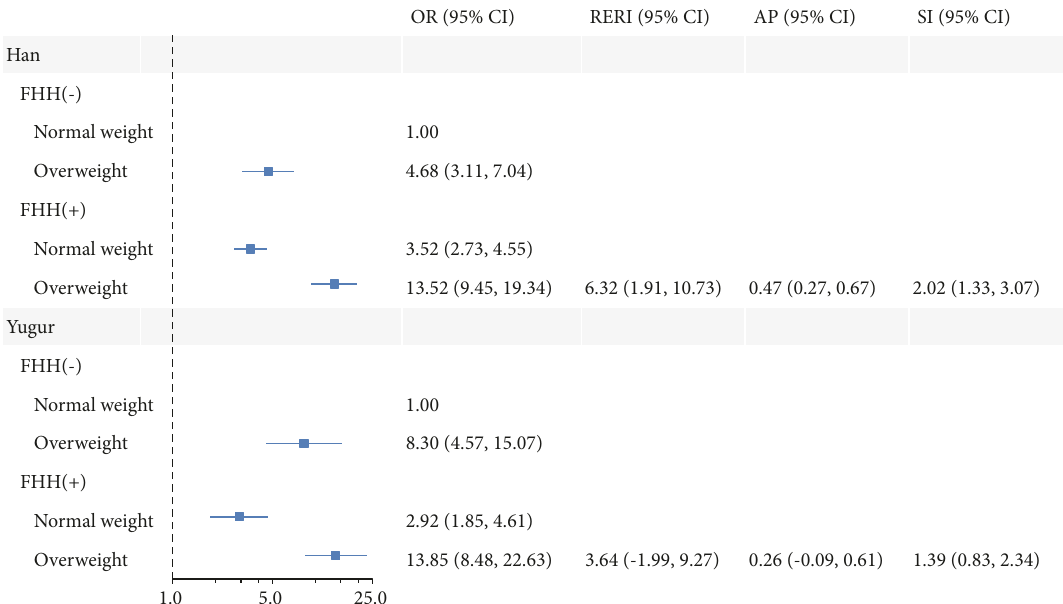
Figure 3: Associations and interactions of obesity and FHH on hypertension in Han and Yugur people in China. Models were adjusted for age and gender. FHH: family history of hypertension, RERI: the relative excess risk due to interaction, AP: the attributable proportion due to interaction, SI: the synergy index. Interaction was present if the 95% CIs of RERI and AP did not include 0 and the 95% CI of SI did not include 1.